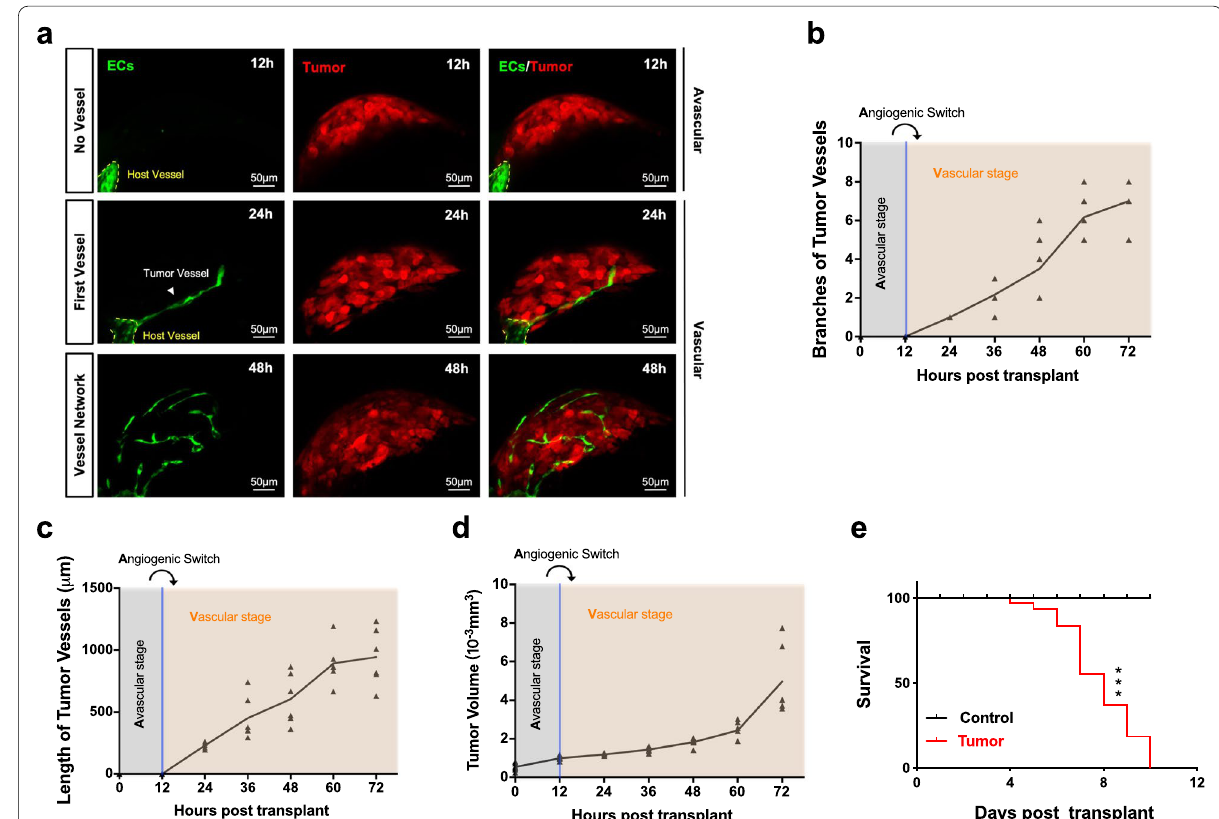
Fig. 1 Angiogenic switch model in zebrafish. a Imaging of the tumor vascular growth with a confocal microscope. The first column indicates that the transplant microtumor does not yet have blood vessels (No vessel, Avascular phase). The second and third columns indicate the presence of blood vessels in the transplant microtumor (First vessel, Vessel network; Vascular phase). Endothelial cells (ECs) are green. Tumor is red. Yellow line, host vessel. White arrow, tumor vessel. Scale bar, 50 μm. b The branches and c length of tumor vessels and d tumor volume post tumor cells transplant for 72 h ( n 6). Light blue shade, avascular stage. Light orange shade, vascular stage. Light black curved arrow, angiogenic switch. e . = Survival curve for zebrafish with or without transplant tumor cells for 10 days ( n